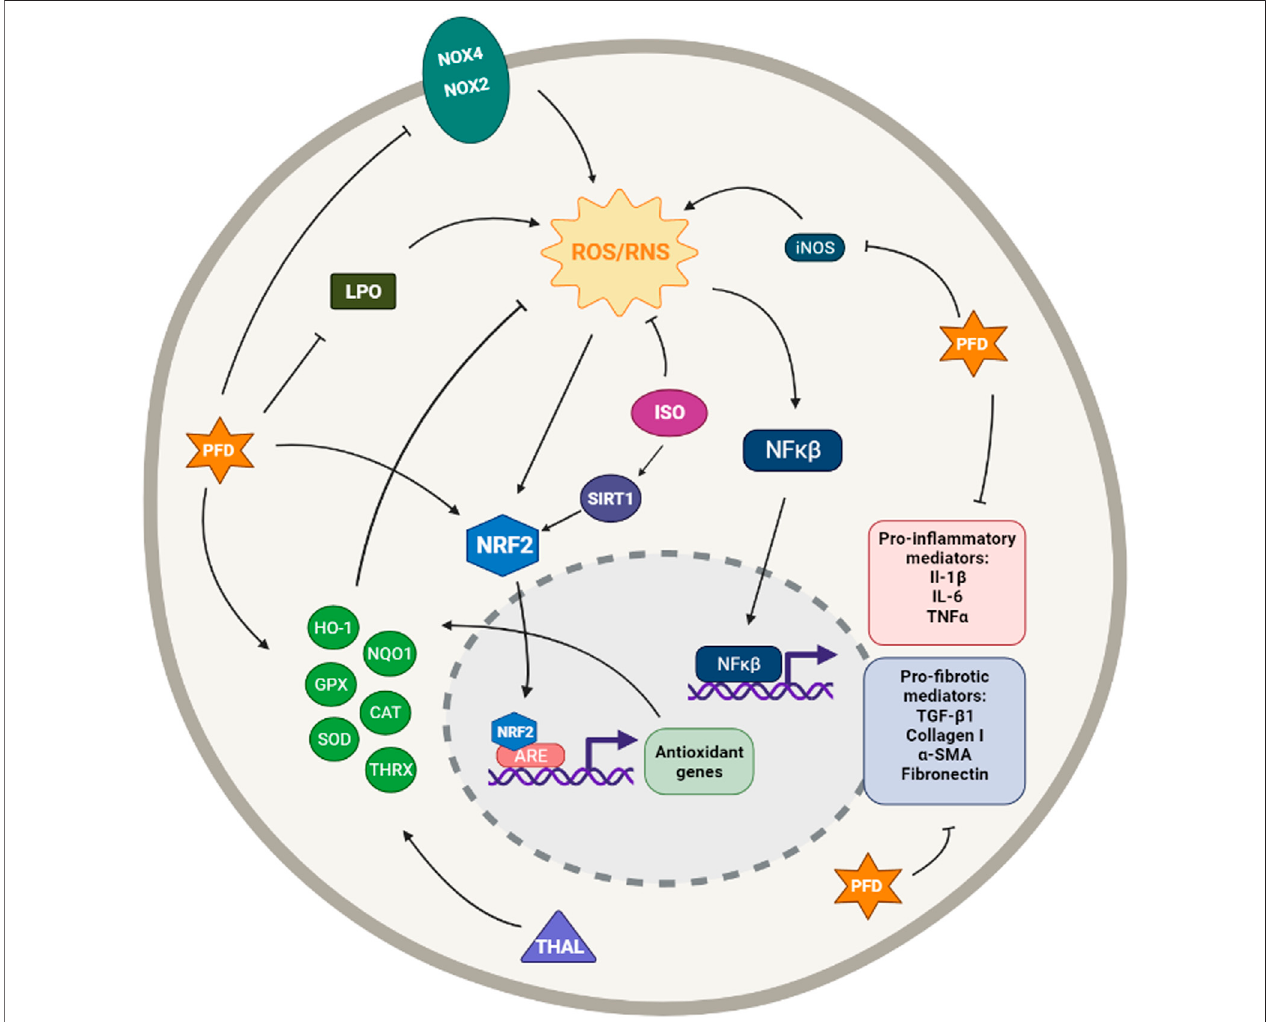
FIGURE5| Simpli fi ed diagram oftheprincipal molecularmechanisms oftheantioxidantenhancers Pirfenidone (PFD), Thalidomide(THAL) and Isorhamnetin (ISO). α SMA: alpha smooth muscle actin; ARE: antioxidant responsive element; CAT: catalase; CYS: cysteine; GLUT: glutamate; GPX: glutathione peroxidase; HO-1: heme oxygenase 1; IL-1 β : interleuquina 1beta; IL-6: interleuquina 6; iNOS: inducible nitrogen oxide synthase; LPO: lipoperoxidation; NF κβ : nuclear factor kappa beta; NOX1,2,4: NADPH oxidases; NQO1: NAD(P)H:quinone oxidoreductase 1; NRF2: nuclear factor erythroid 2-related factor 2; ROS/RNS: reactive oxygen species/ reactive nitrogen species; TGF- β 1: transforming growth factor beta 1; THRX: thioredoxin; TNF α : tumoral necrosis factor alpha; SIRT: sirtuine 1; SOD: supeoxide dismutase Created with Biorender.com.